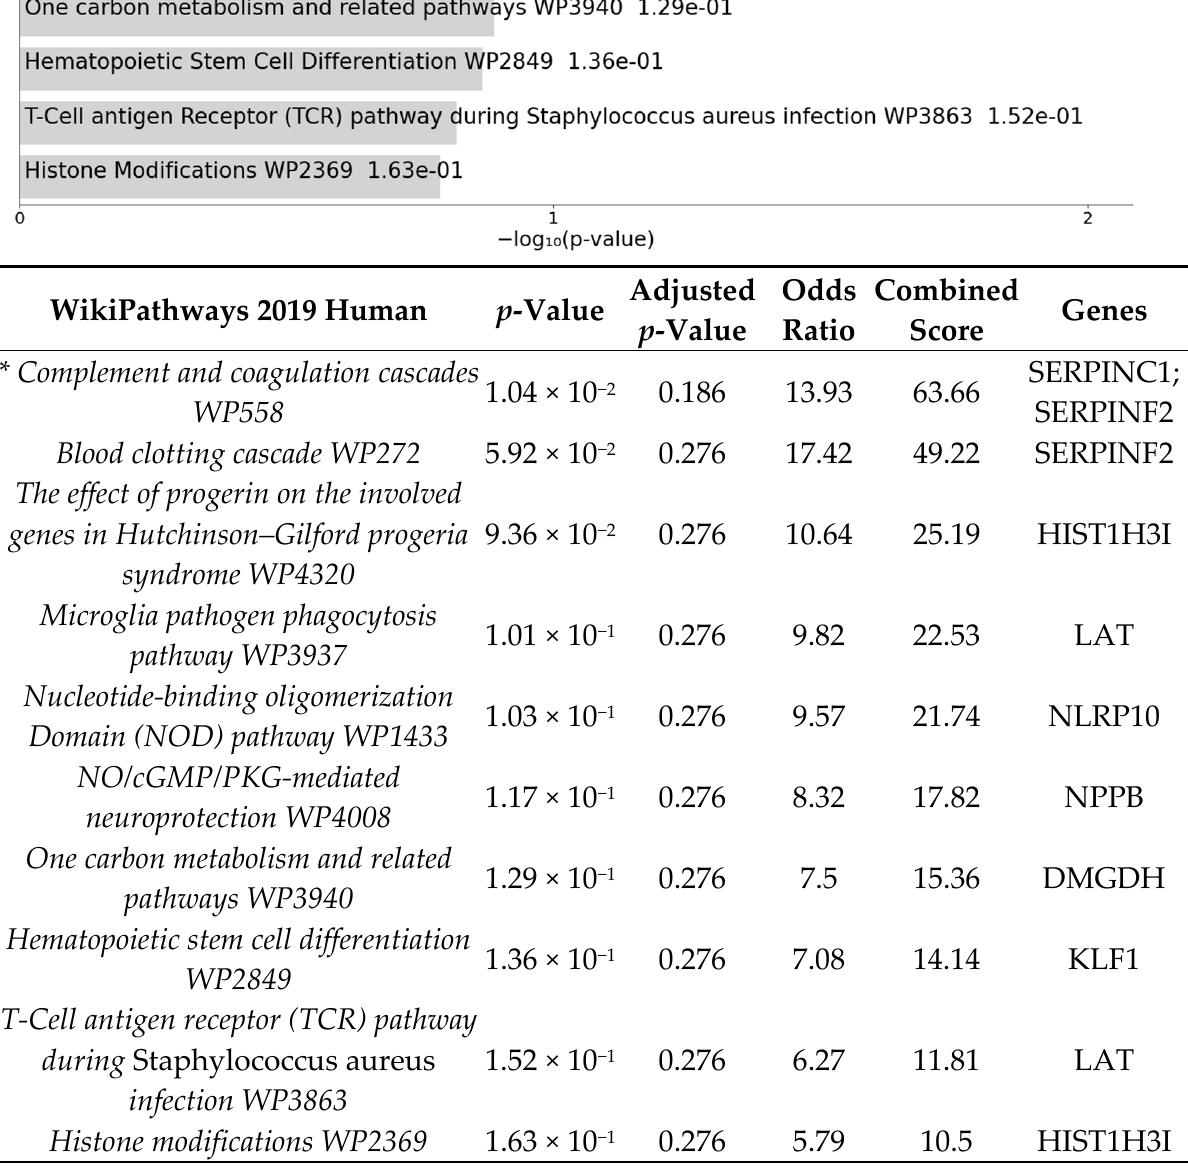
Figure 3. Gene list enrichment analysis of significant DEGs between GF-HFD mice ( n = 4) and GF-ND mice ( n = 4) using EnrichR. The bar graph shows a ranked list by p -value of the top 10 over-represented human pathways with significant pathways indicated in blue ( p -value < 0.05). The corresponding table demonstrates detailed statistics and involved genes with significant pathways indicated by an asterisk ( p -value < 0.05).